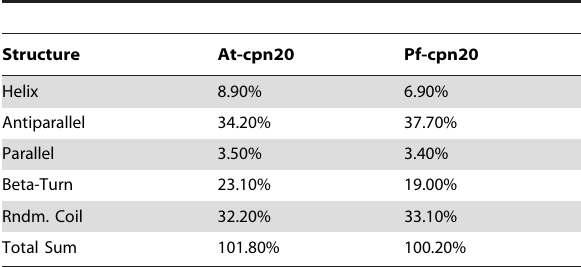
Table 1. Deconvolution of CD data for At-cpn20 and Pf- cpn20*.